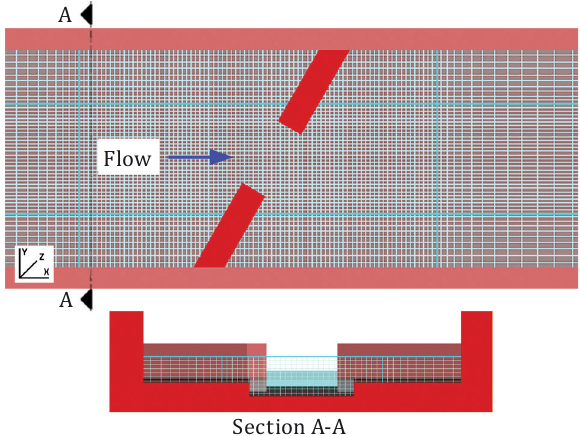
Figure 7. Computational grid: 2D mesh and cross-section for Seckin’s (2007) laboratory model at a 30° skew angle